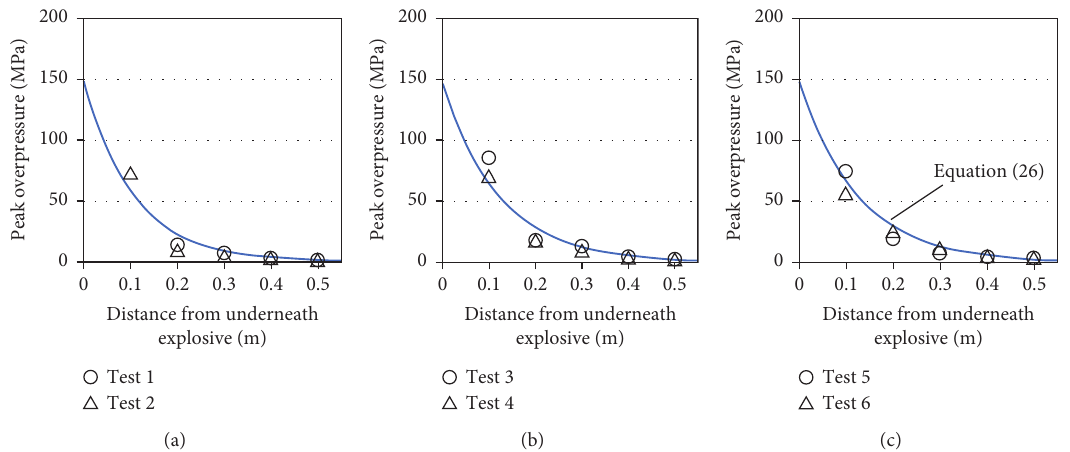
Figure 15: Peak overpressure data at different distances from the underneath explosive [19]: (a) nos.1-2 (110g), (b) nos. 3-4 (160g), and (c) nos. 5-6 (250 g).